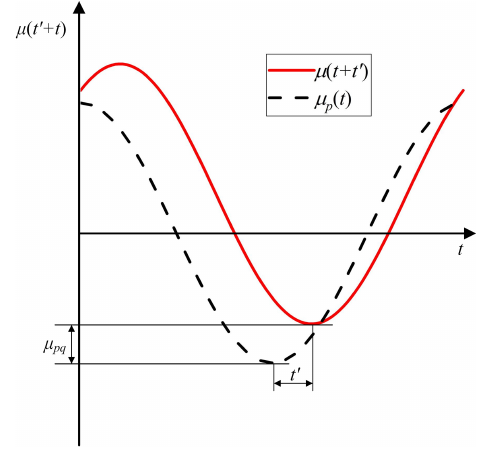
Figure 7. The translation of the orientation output